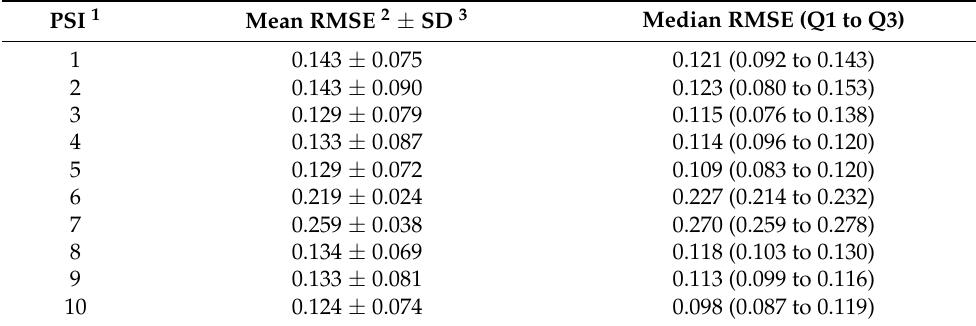
Table 1. Quantitative assessment for dimensional repeatability of material extrusion 3D-printed PEEK patient-specific cranial implants.